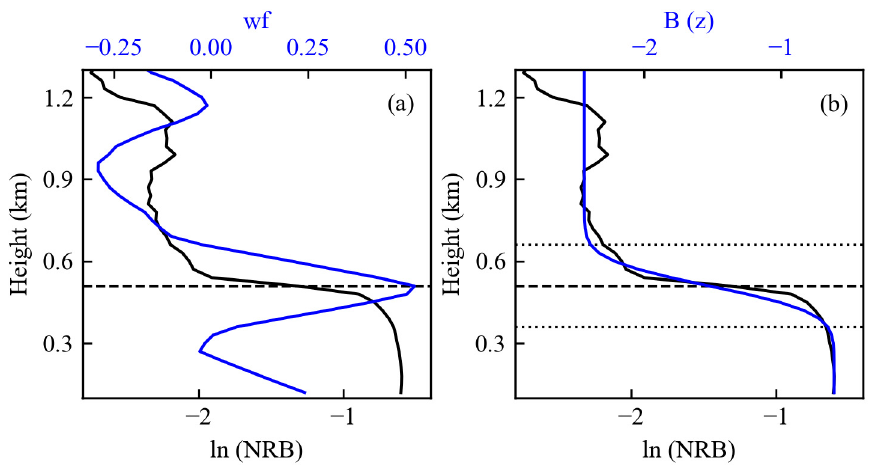
Figure 3. BLH estimated using ( a ) WCT and ( b ) FIT with lidar ln (NRB) profile for 14:00 (Beijing time) on 12 December 2019.